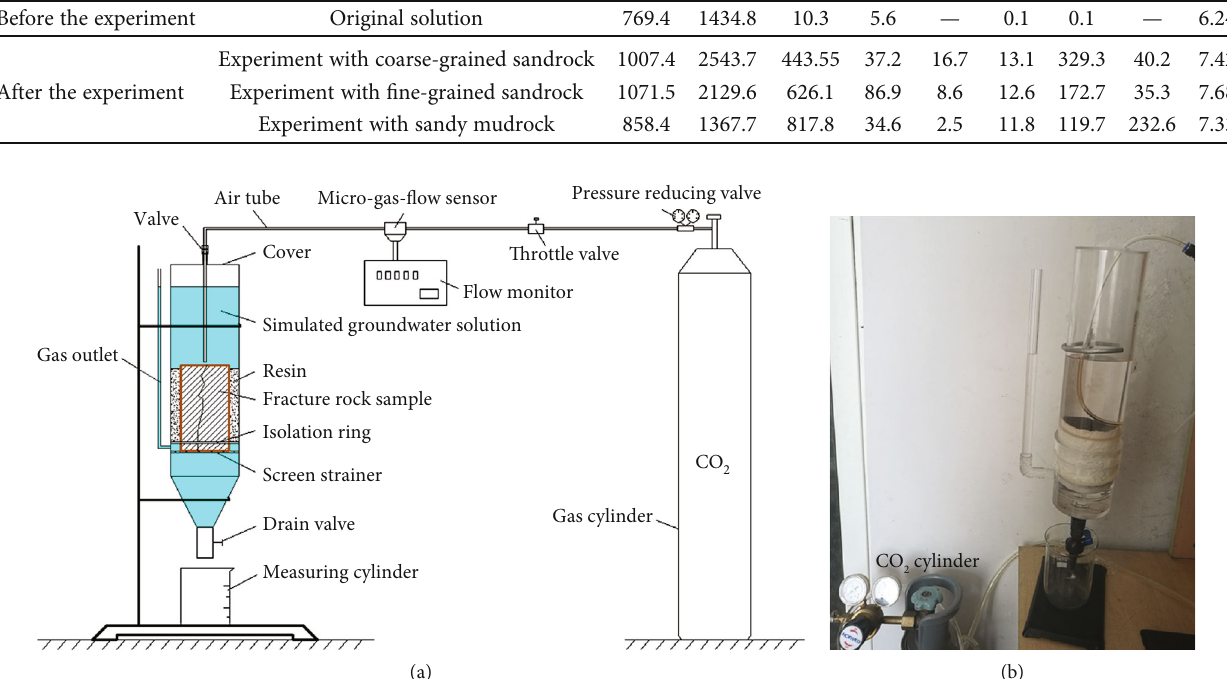
Figure 2: Set-up for the water-CO